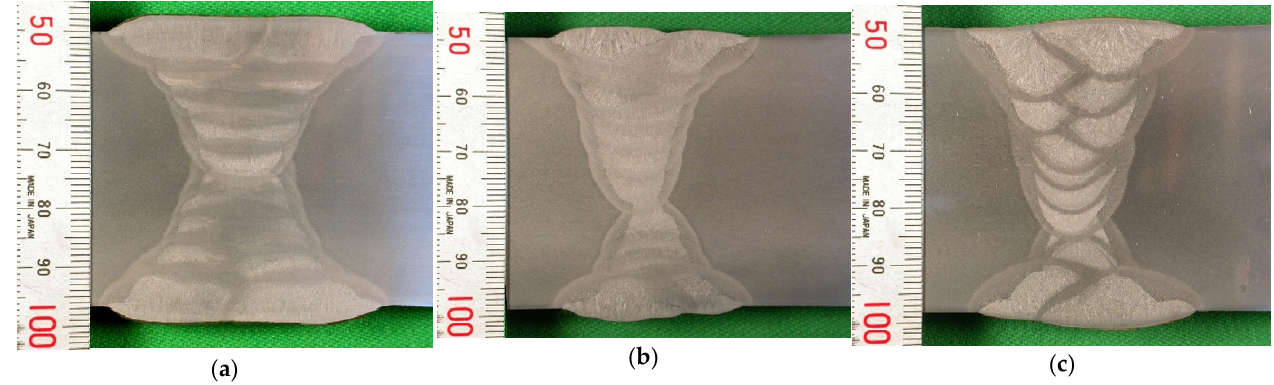
Figure 3. Macrostructure of weldment: ( a ) FCAW with overheat input condition; ( b ) FCAW with normal heat input condition; ( c ) SAW with normal heat input condition. Table 1. Chemical composition of the base metal and weld metal. (wt.%)